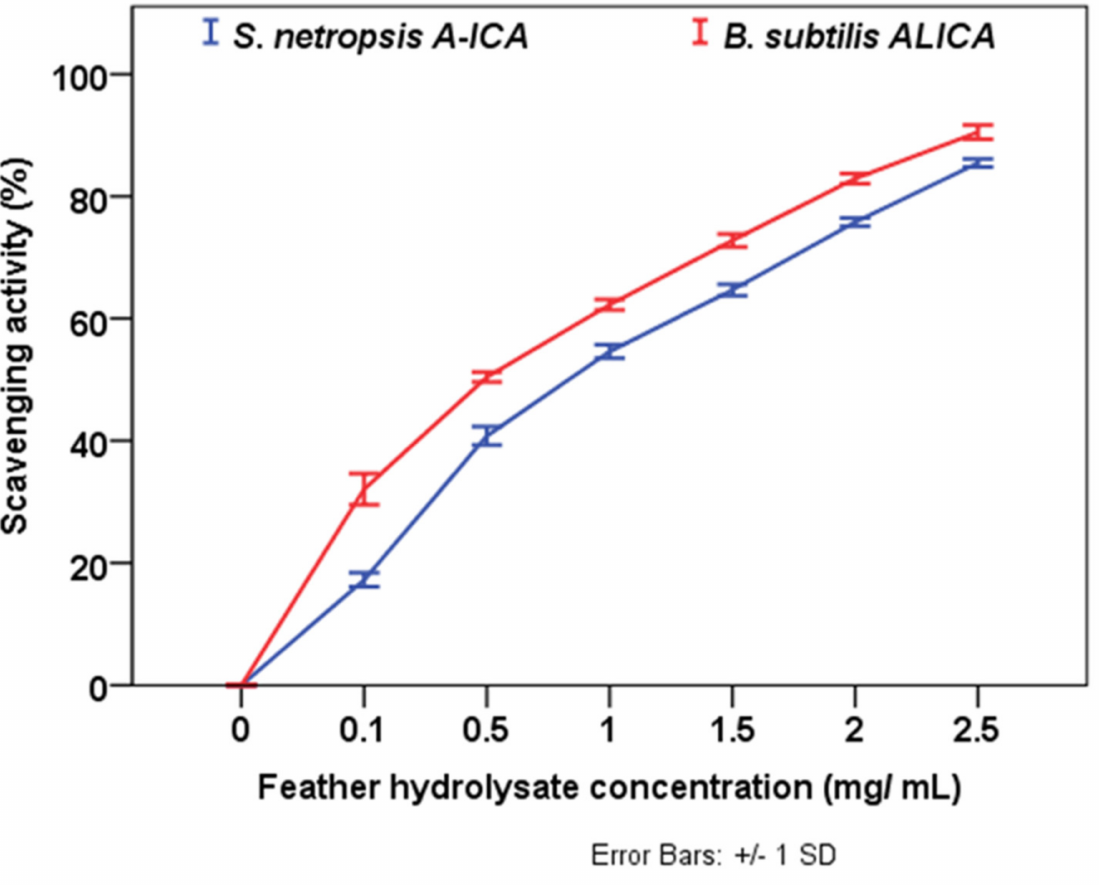
Figure 4. Inhibition percentage of DPPH antioxidant activity of feather